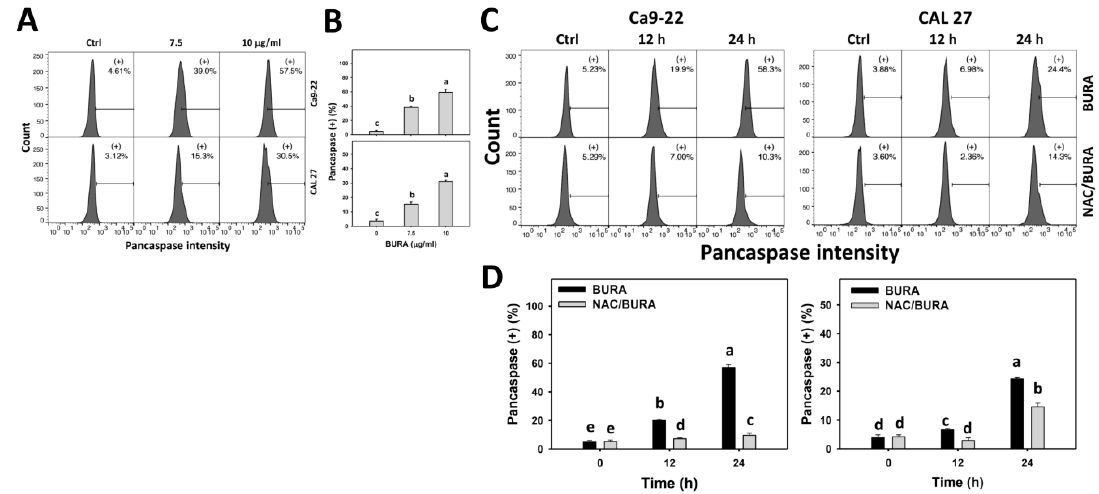
Figure 4. BURA causes pancaspase activation in oral cancer cells. ( A , B ) Pancaspase pattern and quantification. Oral cancer cells (Ca9-22 and CAL 27) were treated with BURA (control (0.1% DMSO), 7.5 µ g/mL (25.3 µ M), and 10 µ g/mL (33.8 µ M), 24 h). (+) located within the patterns represent pancaspase (+). ( C , D ) NAC effect on pancaspase pattern and quantification. After NAC treatment (10 mM, 1 h), cells were treated with BURA (10 µ g/mL) for 0 (control), 12 and 24 h. Data, mean ± SD ( n = 3). Data top-labeled with non-overlapping lower-case letters differ significantly according to multi-comparisons ( p <